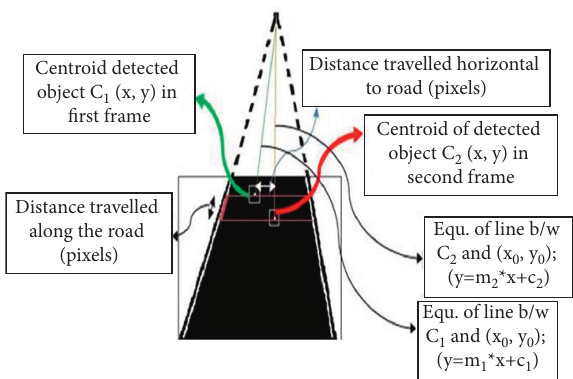
Figure 5: Explanation of distance travelled along and horizontal to the road.